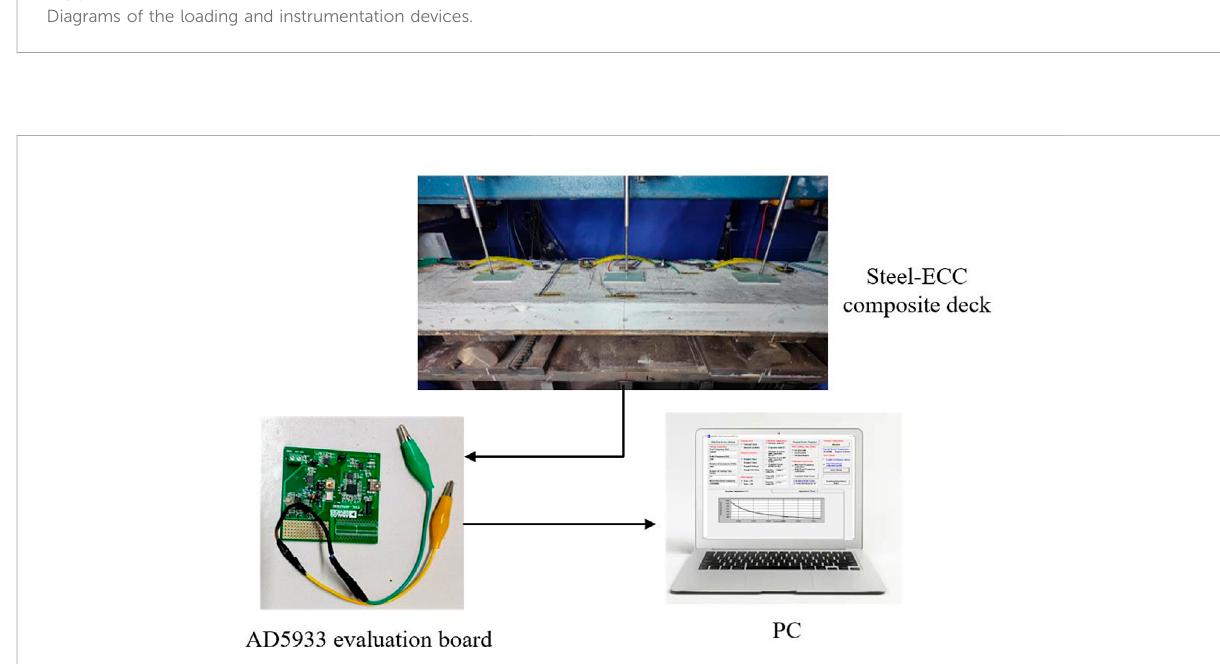
FIGURE 3 Experimental